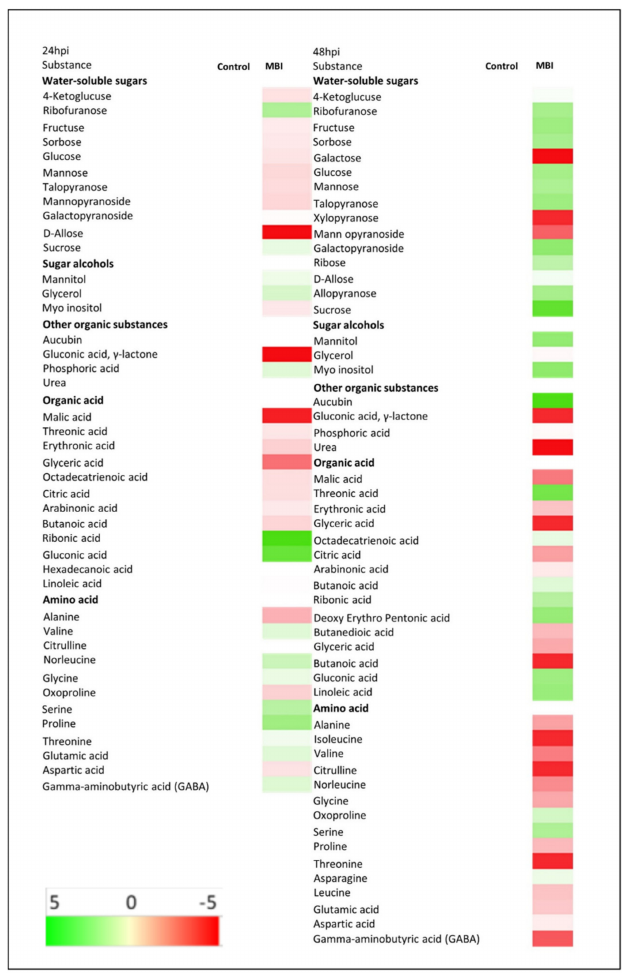
Figure 6. The heatmap of metabolites changes in cucumber leaves of plants treated with Bacillus subtilis MBI600 compared to non-treated plants, sampled, and analyzed by GC-MS, 24 (24 hpi) and 48 (48 hpi) hours post-application of the biocontrol agent. A decrease in metabolites concentration is indicated by a green color and an increase is indicated by a red color, as explained by the color scale at the bottom of the